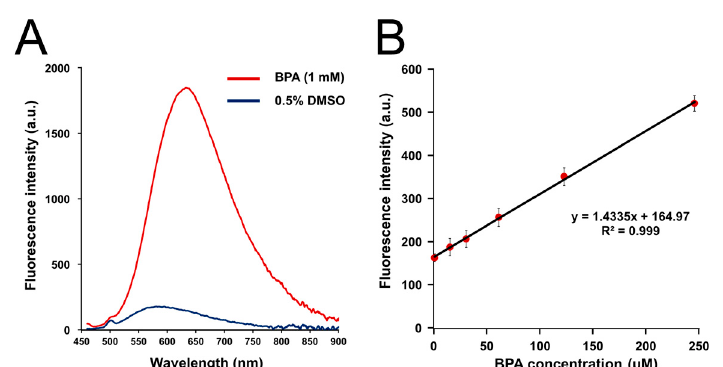
Figure 2. Increase in BS-631 fluorescence intensity in reaction with BPA. ( A ) Emission spectra of BS-631 (100 µ M) 60 min after addition of BPA (0 or 1 mM) in 0.5% DMSO/H 2 O ( λ ex = 430 nm). ( B ) Linear regression analysis between the fluorescence intensities of BS-631 (100 µM) and BPA (0 – 250 µM) in 0.5% DMSO/H 2 O ( λ ex = 430 nm).